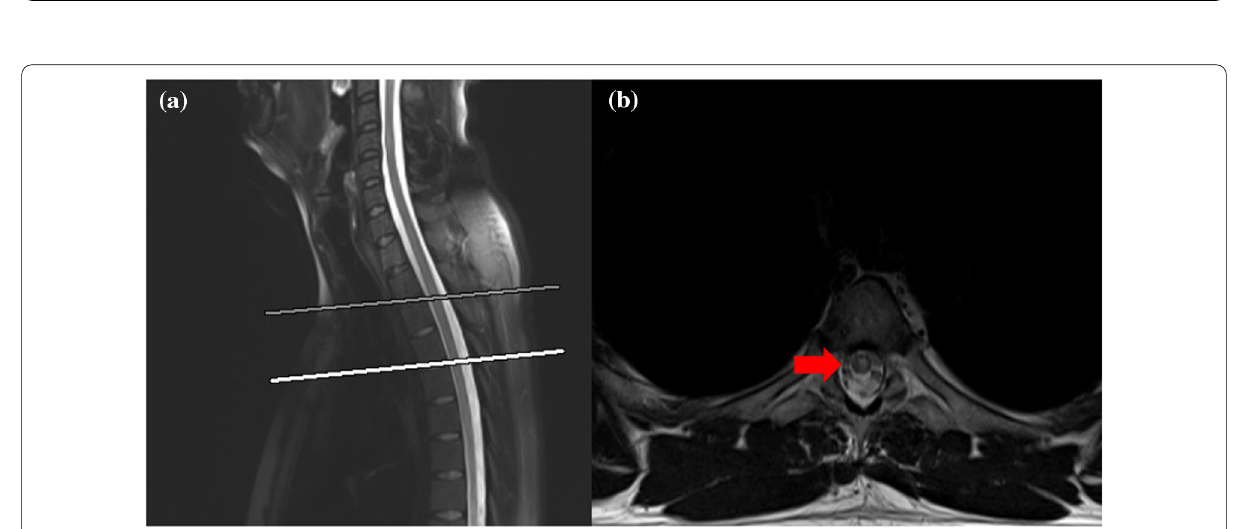
Fig. 2 a Multifocal T2 hyperintense signals involving the cervical and dorsal cord. There are multiple skip segments without continuous involvement. The red arrow indicates T2 hyperintense signals in the spinal cord at T4/5 level in axial plane ( b